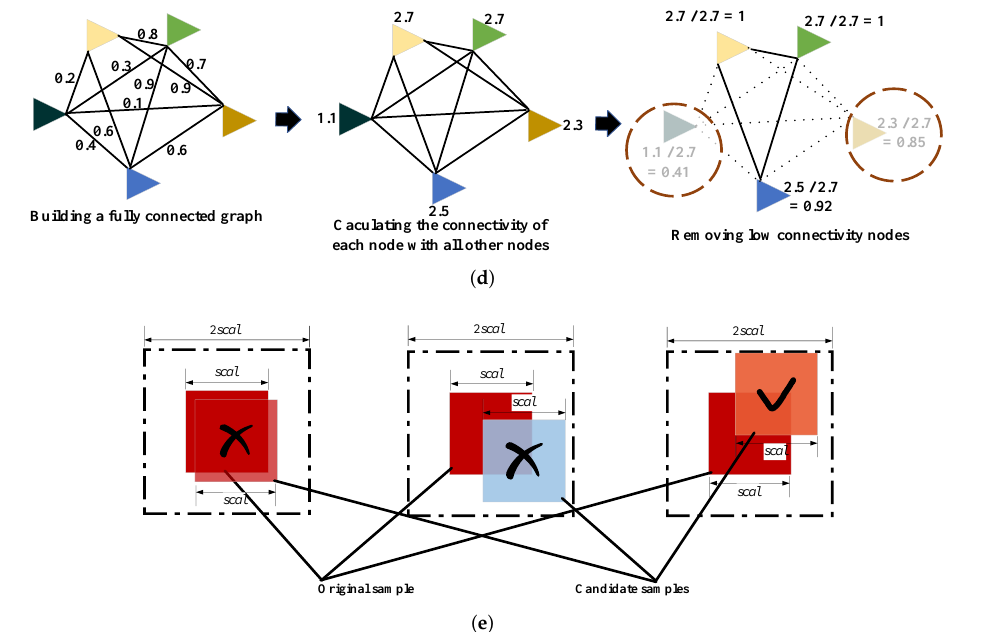
Figure 3. Dataset collection of the UsMsPD. ( a ) Overall generating process of the UsMsPD. It includes four steps to form the UsMsPD: ( b ) unsupervised sampling and clustering; ( c ) cluster fusing; ( d ) data cleaning, and ( e ) positive